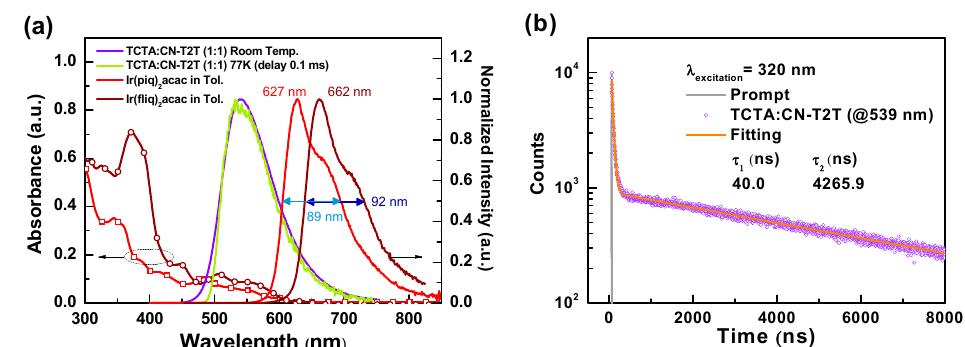
Figure 2. ( a ) Absorption and PL spectra of the TCTA:CN-T2T sample, Ir(piq) 2 acac, and Ir(fliq) 2 acac; ( b ) transient PL profiles of the TCTA:CN-T2T sample.